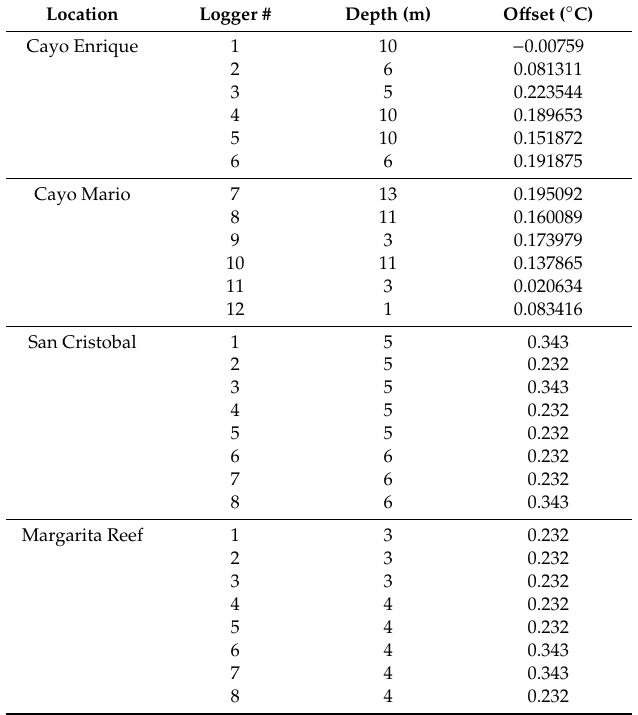
Table 1. Deployment depth of loggers and associated temperature o ff set from the